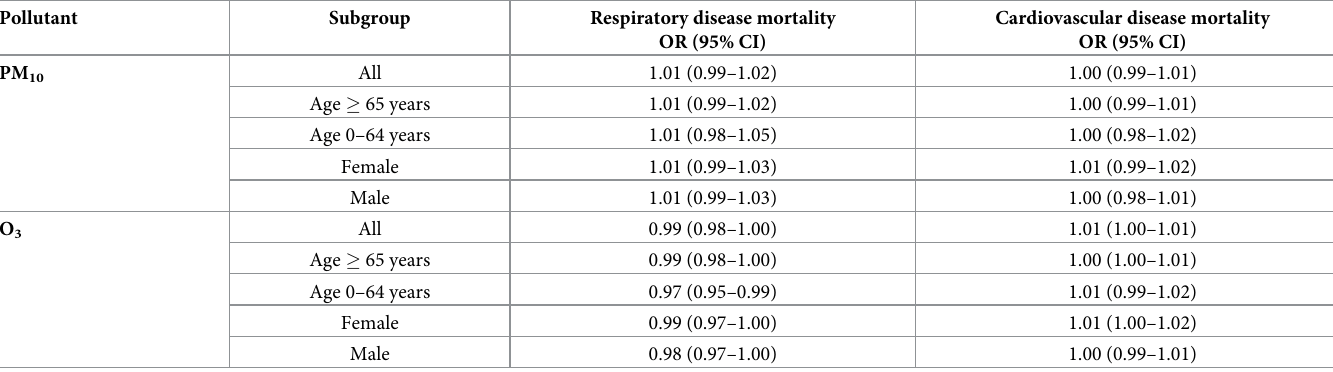
OR: Odds ratio for a 10 μ g/m3 increase in each pollutant exposure.; 95% CI: 95% confidence interval; PM 10 : Particulate matter � 10 μ m; O 3 : Ozone. Models were performed using case-crossover design and adjusted for daily mean temperature and absolute